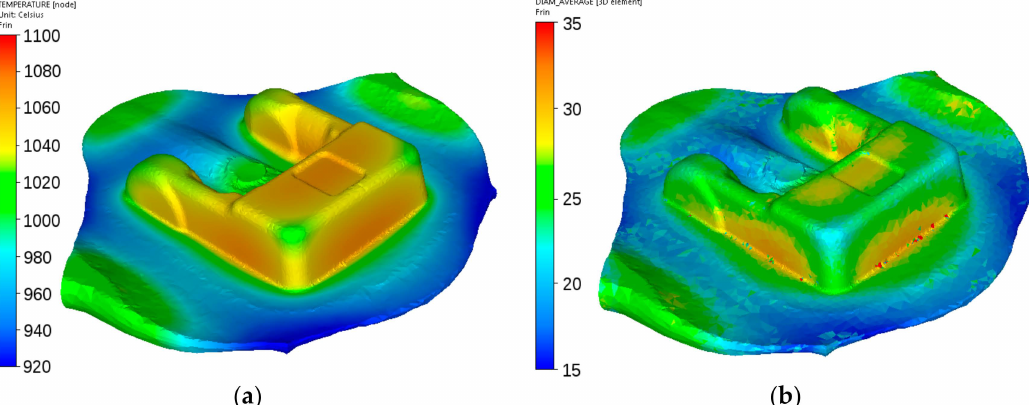
Figure 22. Calculated distributions of the temperature ( a ) and austenite grain size ( b ) after forging of the fork from steel C.